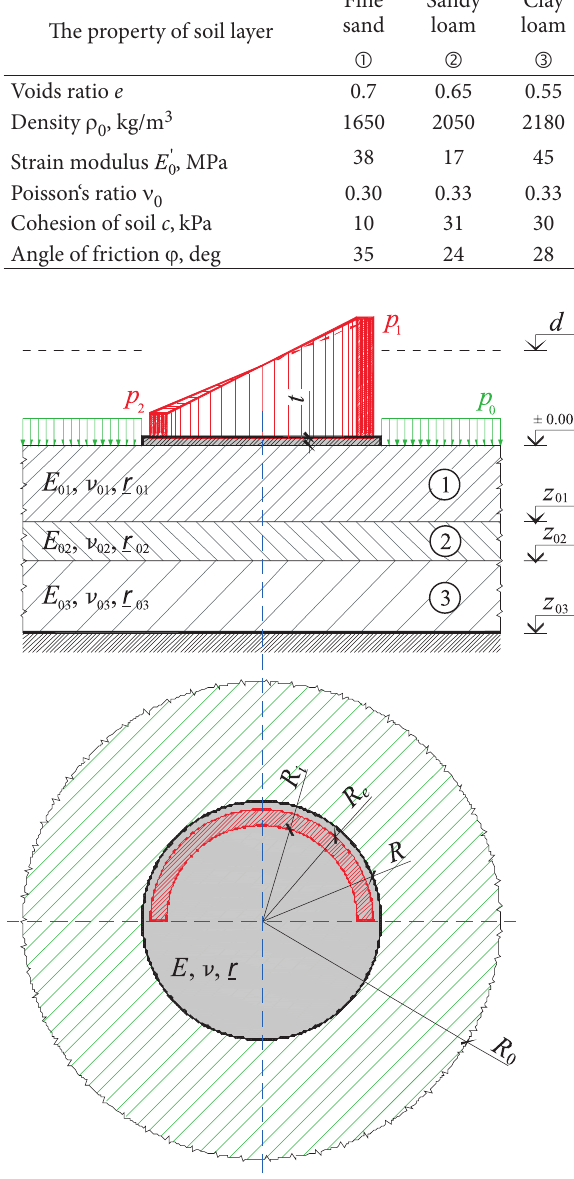
Fig. 1. Design schema of the